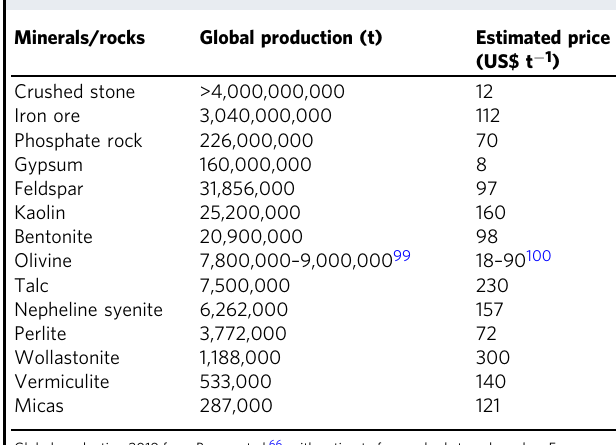
Table 1 Estimated size of global market for industrial mineral commodities, expressed as production statistics, and guide